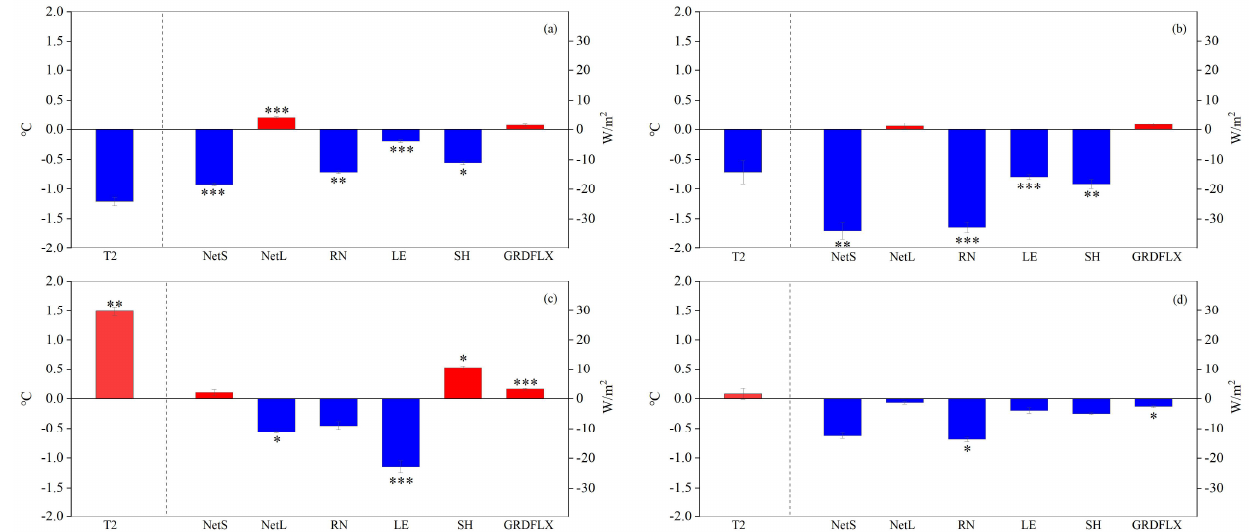
Figure 4. Differences (all-grassland scenario minus the forested scenario) in net shortwave radiation (NetS), net longwave radiation (NetL), net radiation (RN), latent heat flux (LE), sensible heat flux (SH), and ground heat flux (GRDFLX) for the forest ecosystem. ( a ) Winter; ( b ) spring; ( c ) summer; ( d ) autumn. *, **, and *** indicate that the differences are significant at p < 0.05, p < 0.01, and p < 0.001, respectively.